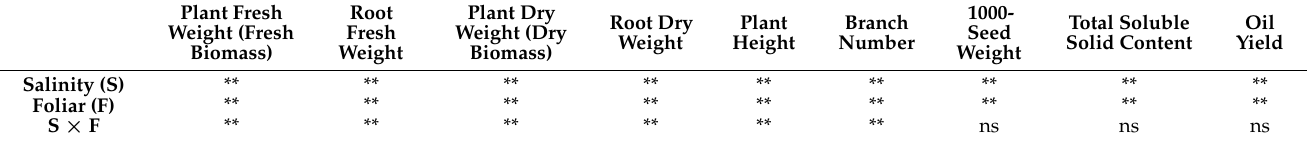
Table 1. ANOVA for the effect of salinity (0–50 and 100 mM NaCl) and foliar applications (no spray, salicylic acid, CeO 2 -nanoparticles, and CeO 2 :SA-nanoparticles) on Portulaca oleracea growth characteristics, oil yield, and content of total soluble solids.